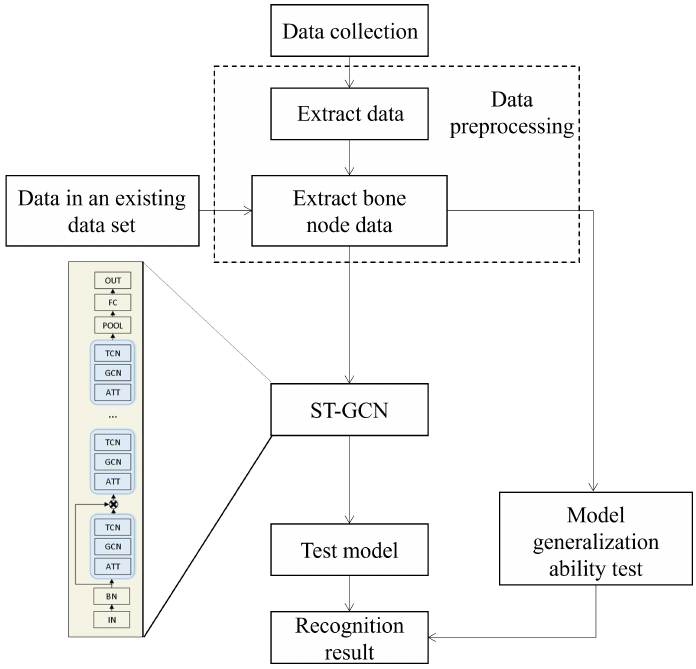
Figure 2. Algorithm refinement flow